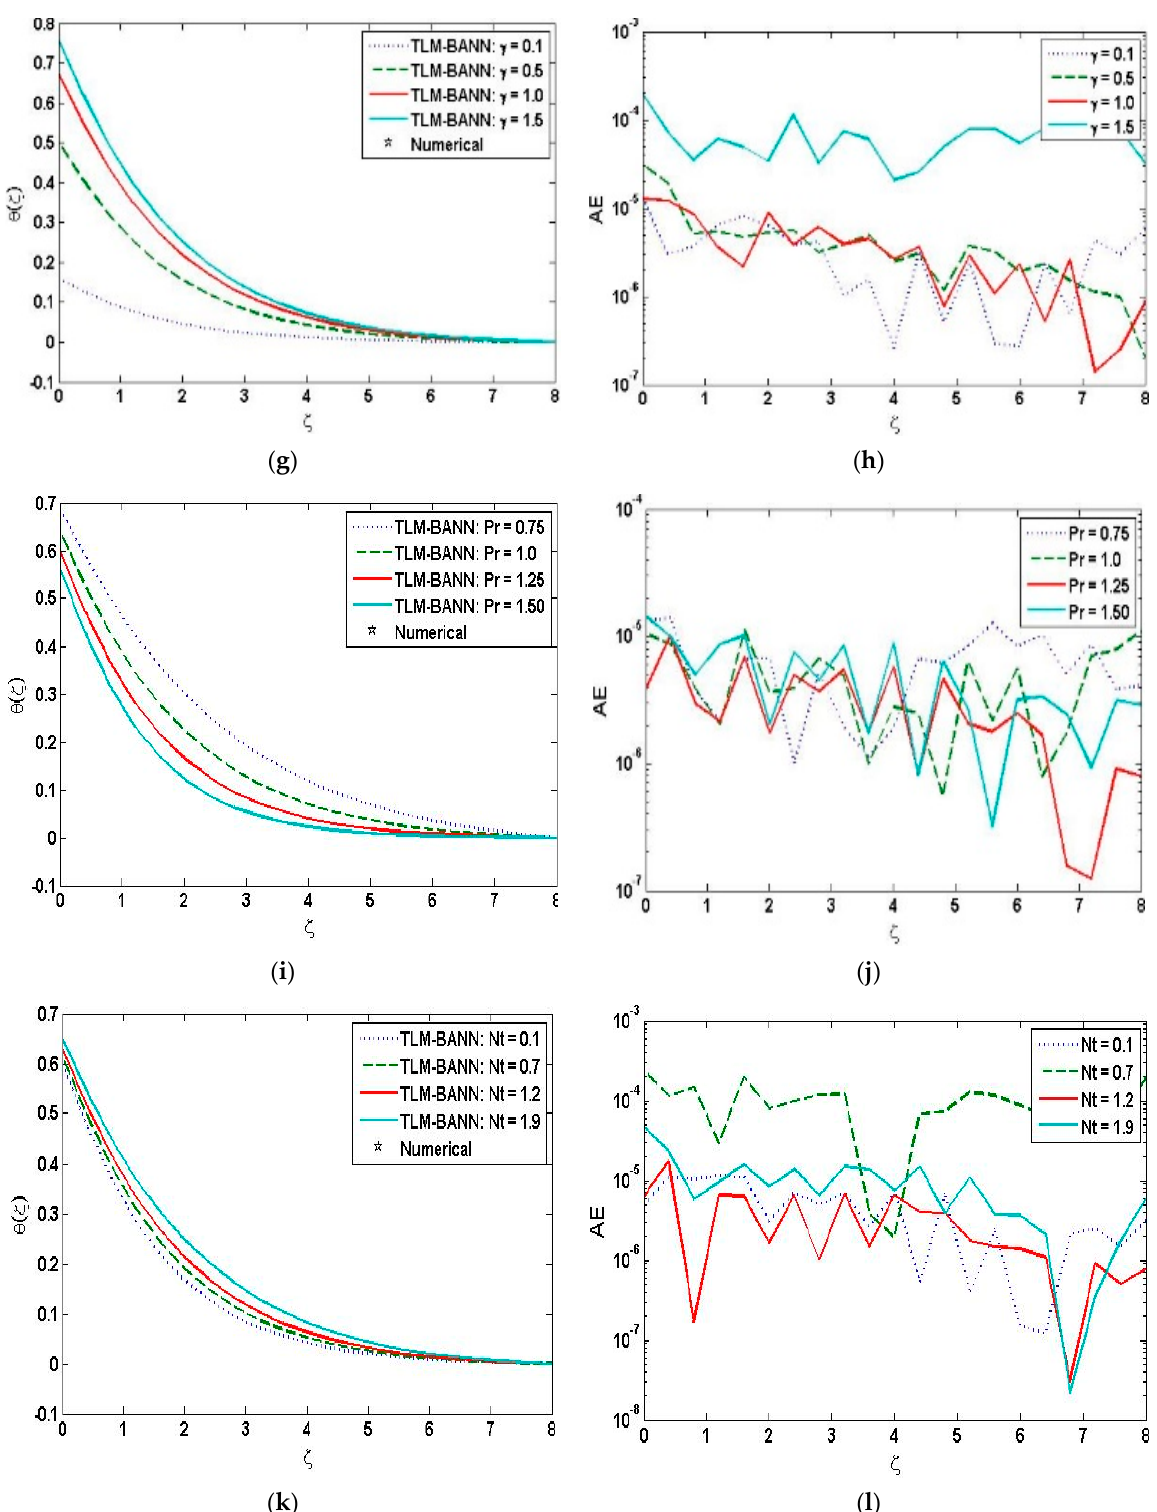
β θ Figure 10. Assessment of TLM-BANN for θ with reference dataset of TD-PNFM ( a ) Variation of β 1 Figure 10. Assessment of TLM-BANN for 𝜃 with reference dataset of TD-PNFM ( a ) Variation of 1 for ; ( b ) AE anal- β β β for θ ; ( b ) AE analysis in variation of β 1 for θ ; ( c ) Variation of β 2 for θ ; ( d ) AE analysis in variation α θ θ θ ysis in variation of 1 for ; ( c ) Variation of 2 for ; ( d ) AE analysis in variation of 2 for ; ( e ) Variation of of β 2 for θ ; ( e ) Variation of α for θ ; ( f ) AE analysis in variation of α for θ ; ( g ) Variation of γ for θ ; ( h ) α θ θ θ θ for ; ( f ) AE analysis in variation of for ; ( g ) Variation of γ for ; ( h ) AE analysis in variation of γ for ; ( i ) AE analysis in variation of γ for θ ; ( i ) Variation of Pr for θ ; ( j ) AE analysis in variation of Pr for θ ; ( k ) Variation of N t for θ ( l ) AE analysis in variation of N t for θ